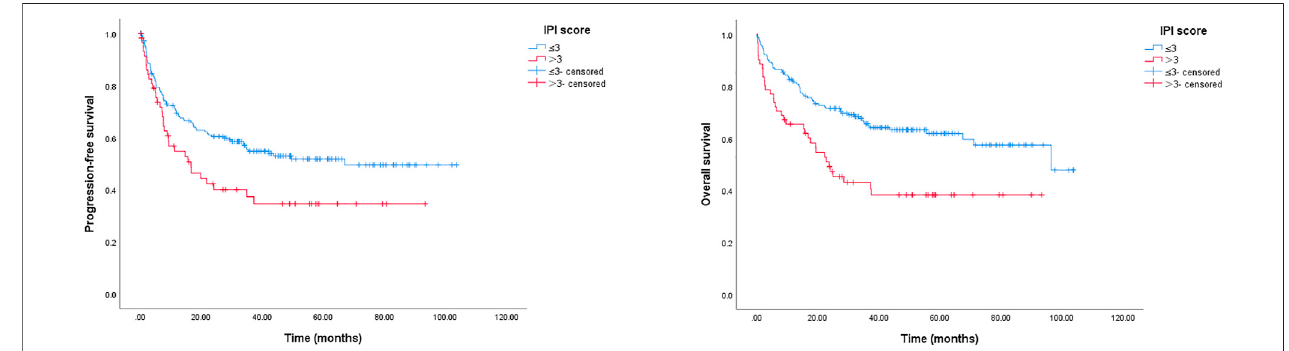
FIGURE5| Kaplan-Meier survivalcurve ofPFS and OS forelderly patientswith DLBCLstrati fi ed byIPI score.The 2-year PFSrates were60.5% (IPI score ≤ 3) and 42.3% (IPI score > 3), respectively, p = 0.021; the 2-year OS rates were 71.5% (IPI score ≤ 3) and 49.2% (IPI score > 3), respectively, p = 0.001.